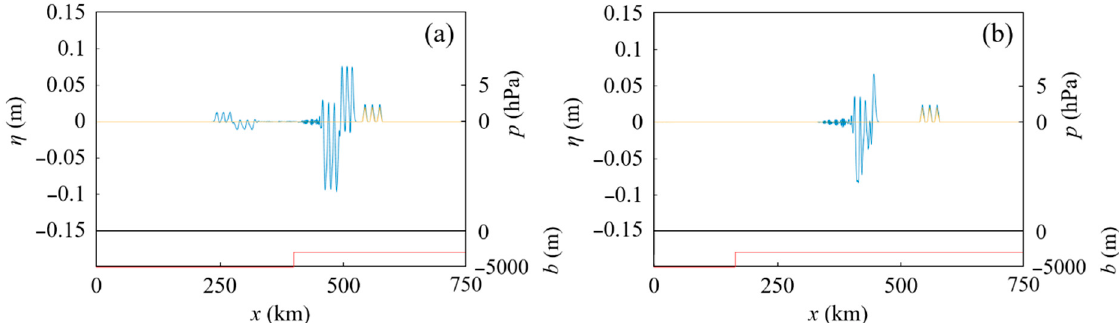
Figure 7. Water surface profiles at t = 2100 s for different offshore end positions of the shallower area, x on , in Case E, in which x 1 = 55 km and δ = 5 km in Figure 1; h on = 3000 m in Figure 2a. The blue, orange, and red lines indicate the water surface displacement η , atmospheric pressure p , and seabed position b , respectively. ( a ) x on = 400 km and ( b ) x on = 170 km in Figure 2a.